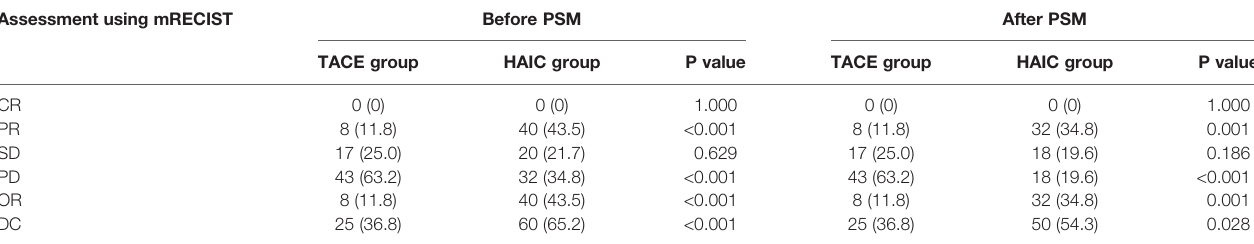
TABLE 2 | Treatment responds between TACE group and HAIF